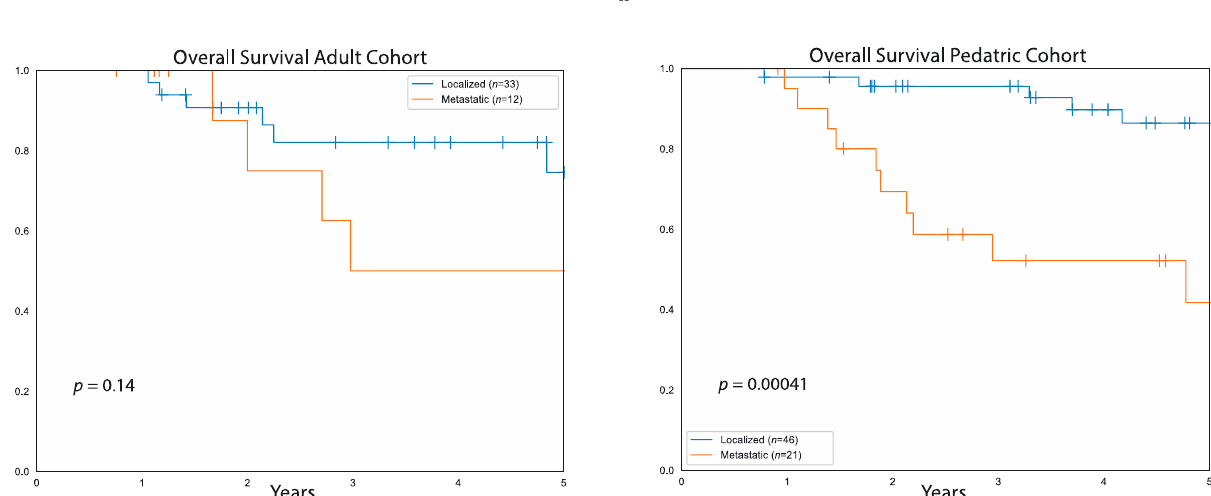
Figure 5. Relationship between OS and metastatic disease at diagnosis. ( a ) Data shows overall survival in the adult cohort for patients with absence of primary metastases (blue curve) and patients with primary metastatic disease (orange curve). ( b ) Overall survival in the pediatric cohort for patients without primary metastatic disease (blue curve) and patients with primary metastases (orange curve).